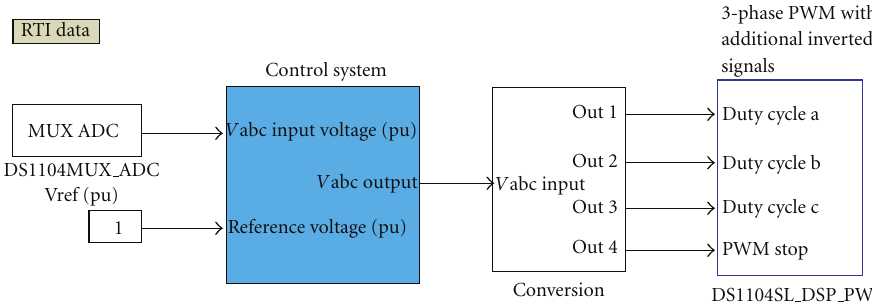
Figure 5: The dSPACE DS1104 RTI control system implementation of the PV inverter system.